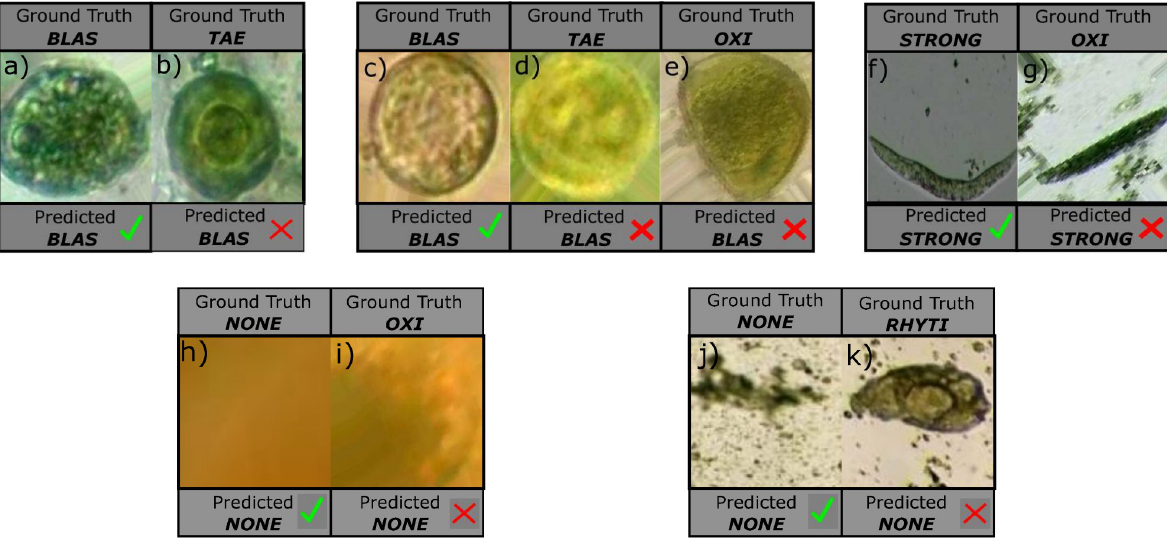
Fig 15. Examples of wrong predictions.